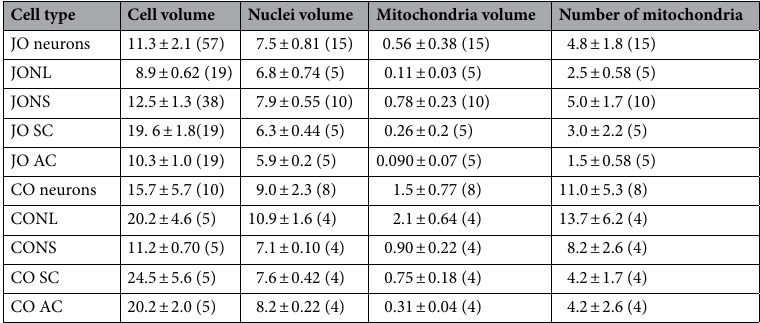
Table 2. Cell and organelle volumes (µm 3 ) and number of mitochondria of female Megaphragma viggianii chordotonal organs, mean ± SD (n), raw data—Table S8,